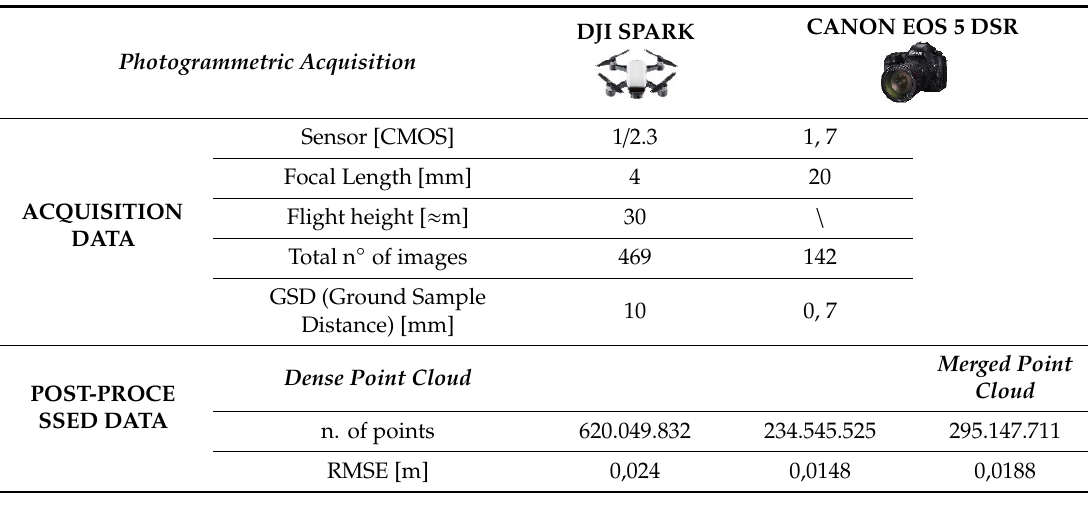
Table 2. Photogrammetric data of acquisition and post-processing phase.